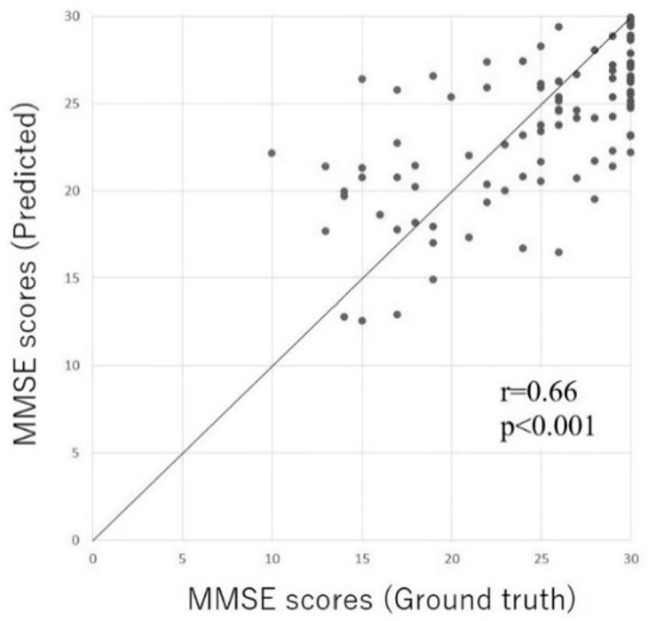
Scatter plot of the predicted MMSE scores and ground truth MMSE scores in the Inpatient and Heathy groups. The horizontal axis represents the measured MMSE score, while the vertical axis indicates the MMSE score predicted by the DL-based screening test.